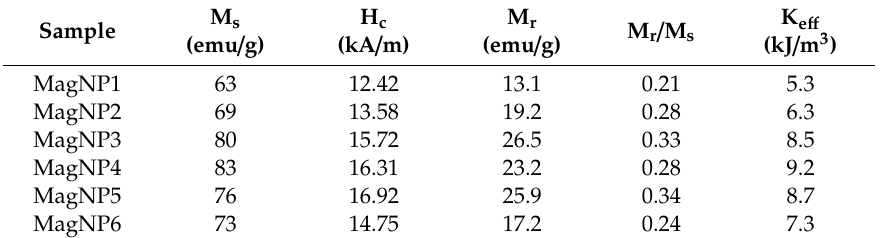
Table 2. Magnetic hysteresis parameters at room temperature for all six types of MagNPs.